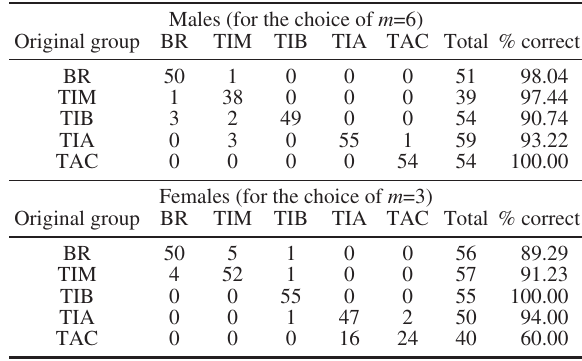
Table 3. – Cross-validation results for canonical analysis of princi- pal coordinates of the Aratus pisonii